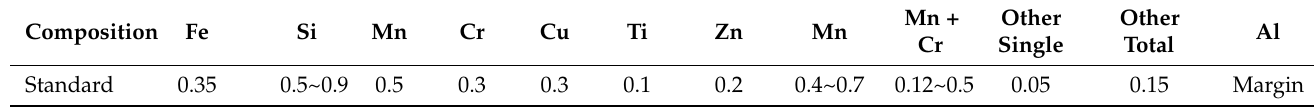
Table 2. Chemical composition of 6005A aluminum alloy (mass